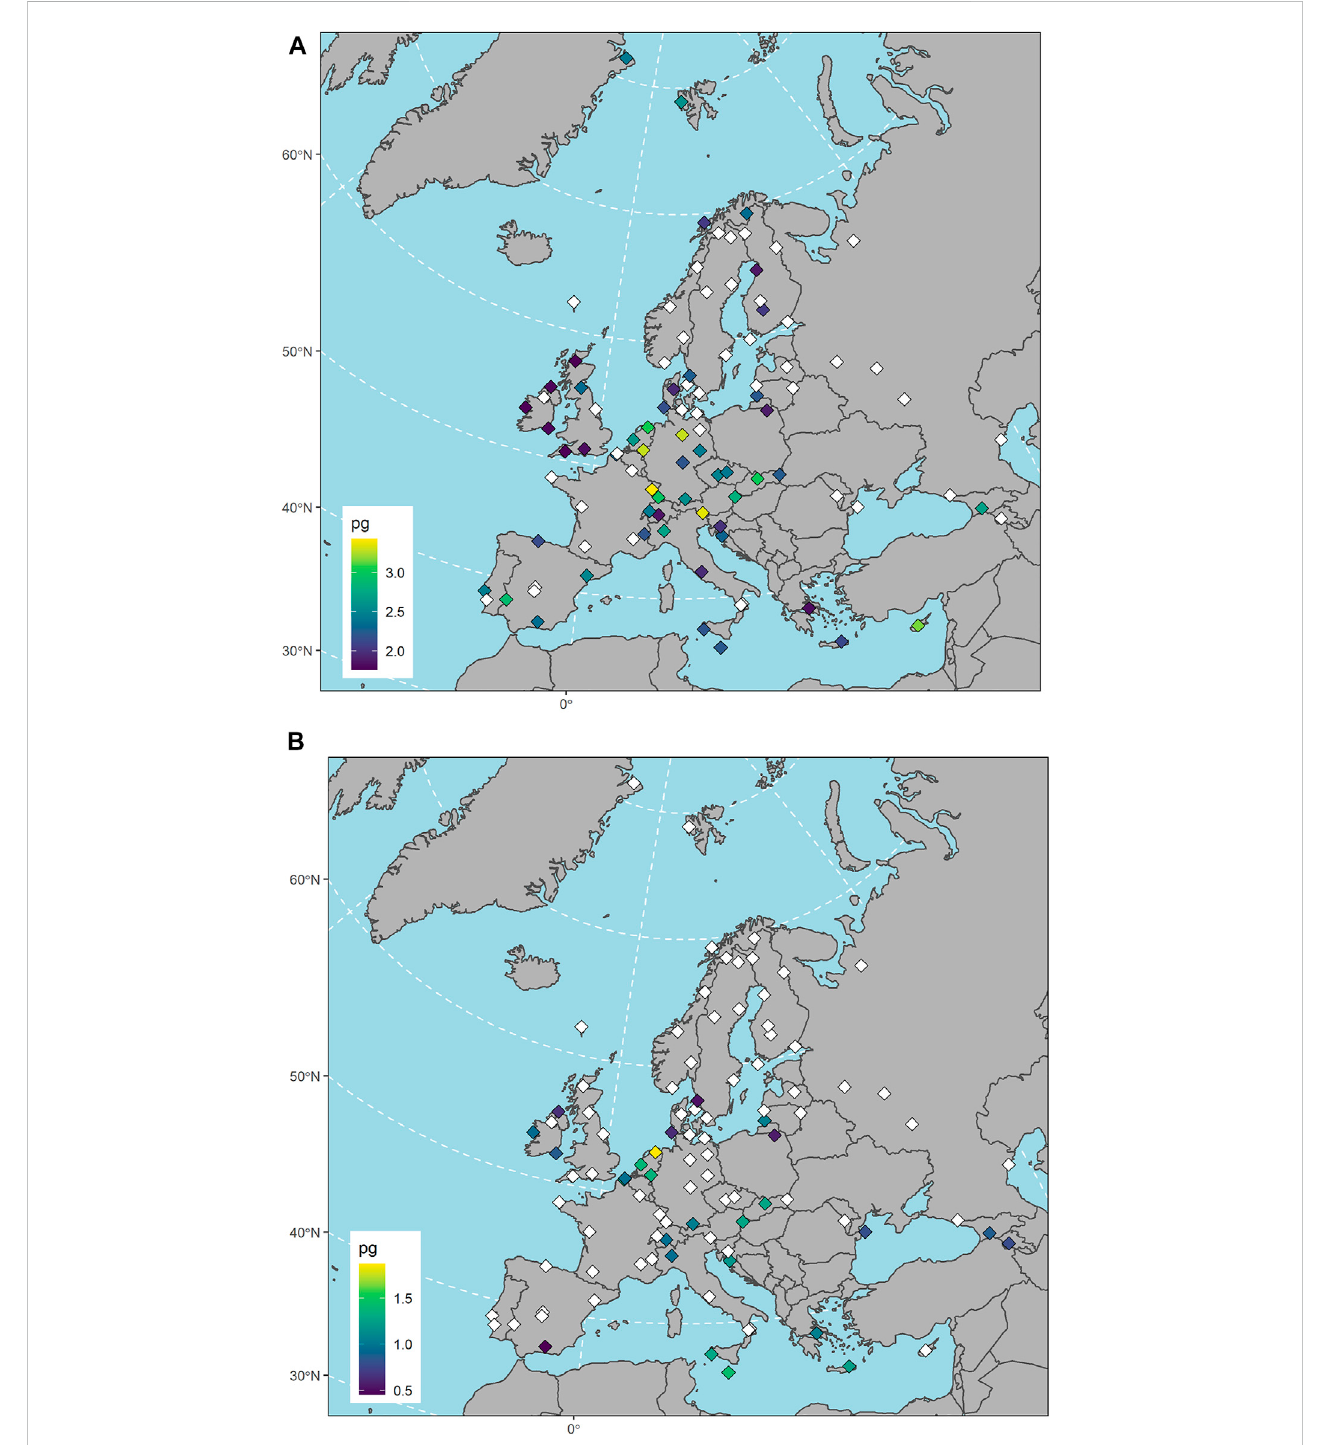
FIGURE 1 Spatialdistributionof Ʃ DP(syn-DP+anti-DP) (A) andDechlorane-602 (B) .Concentrationsaredisplayedaslogpg/sampletoallowforvisualcomparison between the sample locations. Note the different scales between the two maps. Locations with concentrations of both DPs/Dec-602 below MDL are shown as white points. Equivalent maps for syn- and anti-DP separately are given in Supplementary Figure